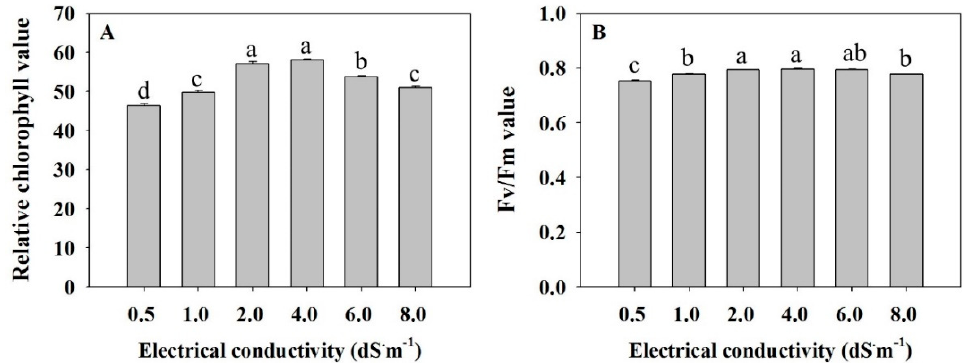
Figure 1. Relative chlorophyll value ( A ) and chlorophyll fluorescence (F v / F m ) ( B ) of A. rugosa at different electrical conductivity (EC) treatments (0.5, 1.0, 2.0, 4.0, 6.0, and 8.0 dS·m − 1 ). The data show the means and the vertical bars show the standard error ( n = 6 and n = 3). Different letters show significant differences among EC treatments (Tukey’s test, p ≤ 0.05).